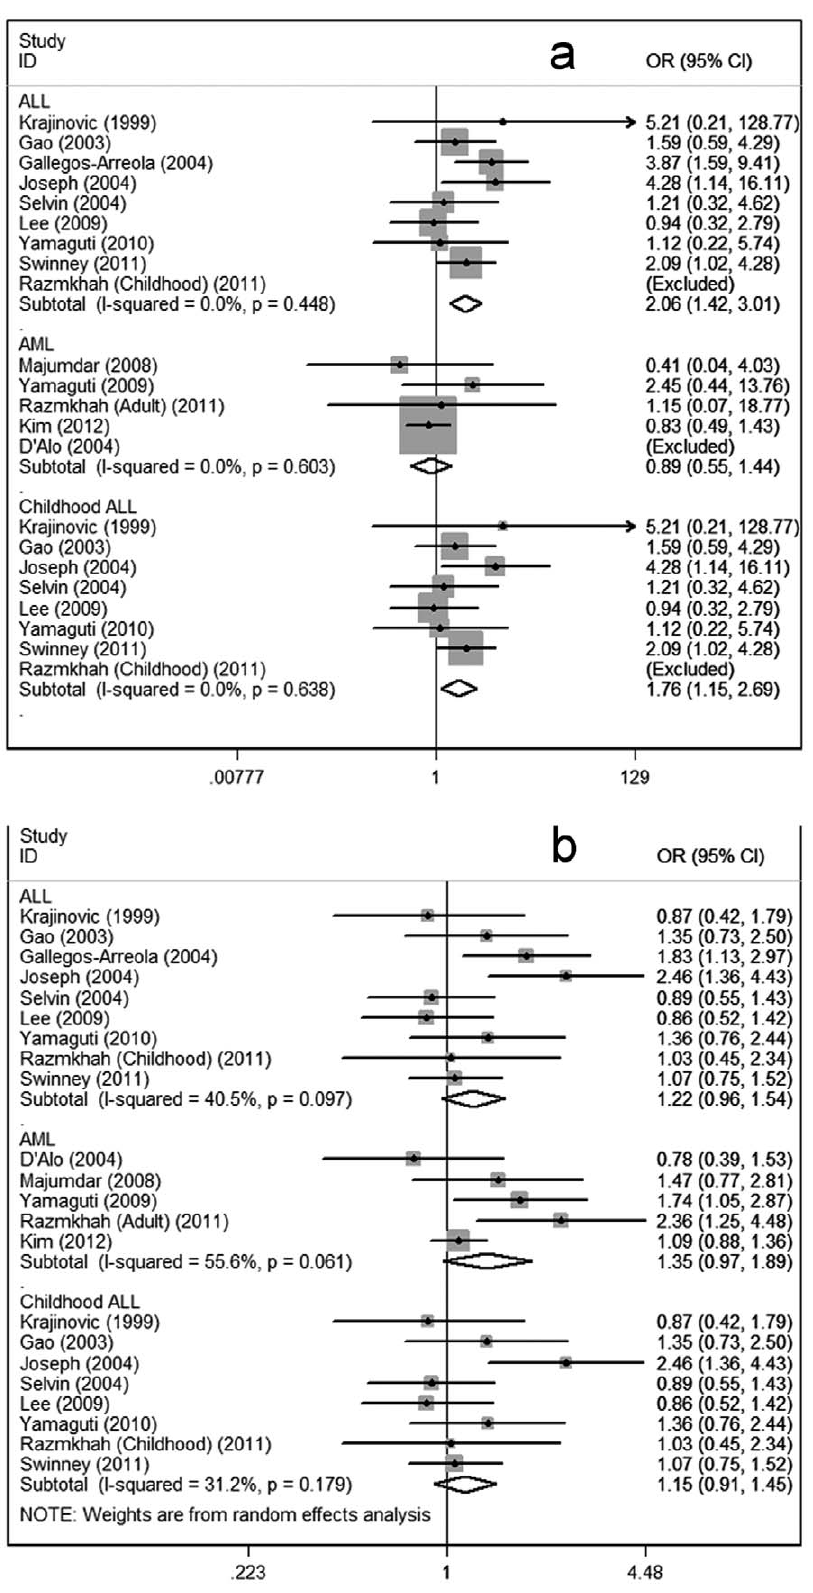
Figure 4. Meta-analysis for the association of acute leukemia risk with CYP1A1 Ile462Val polymorphism stratified by clinical types. (a) Val/Val versus Ile/Ile; (b) Val/Val + Val/Ile versus Ile/Ile; AML, acute myeloid leukemia; ALL, acute lymphocytic leukemia.